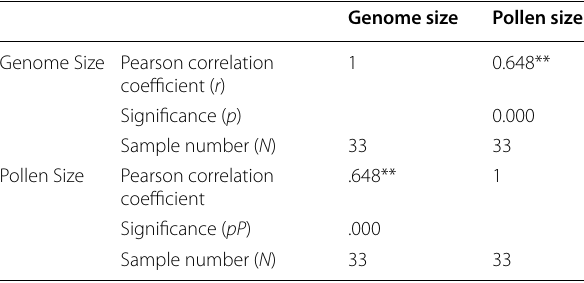
**Represents the correlation reached extremely significant ( p <